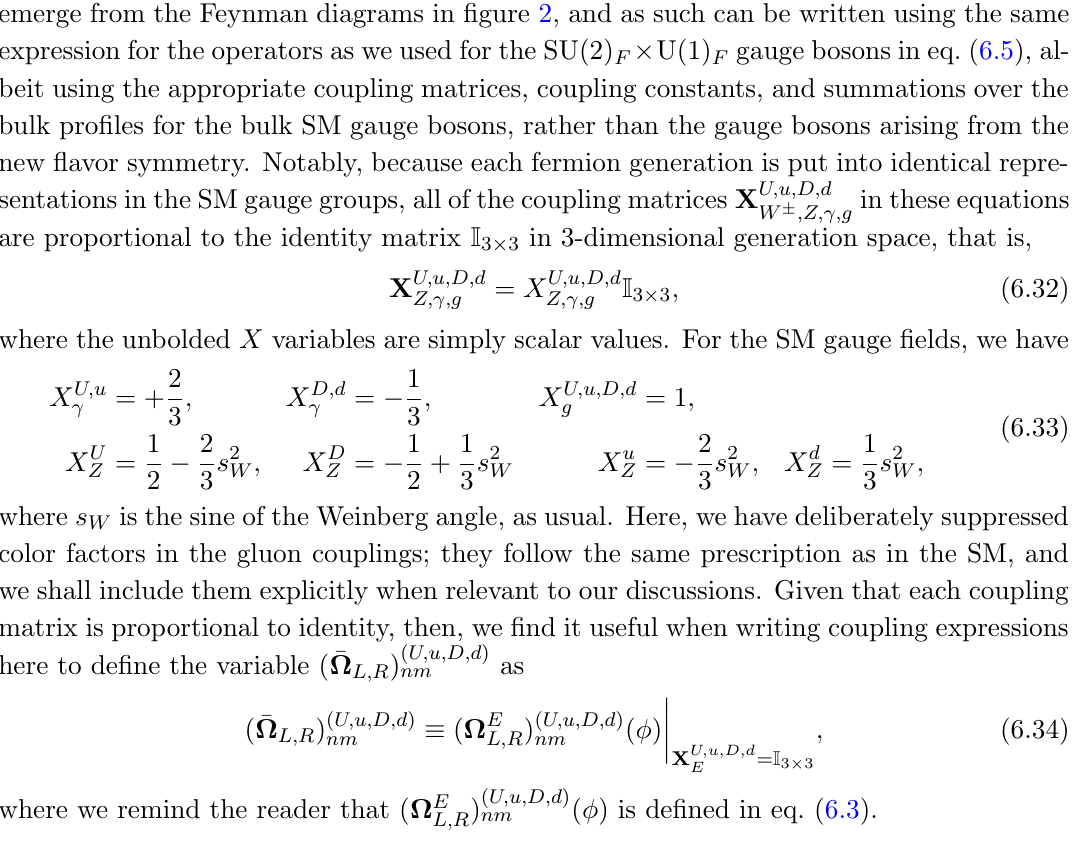
Figure 6. At a sample point in parameter space, the Wilson coe(cid:14)cient P 4 in eq. (6.29), in units of GeV (cid:0) 2